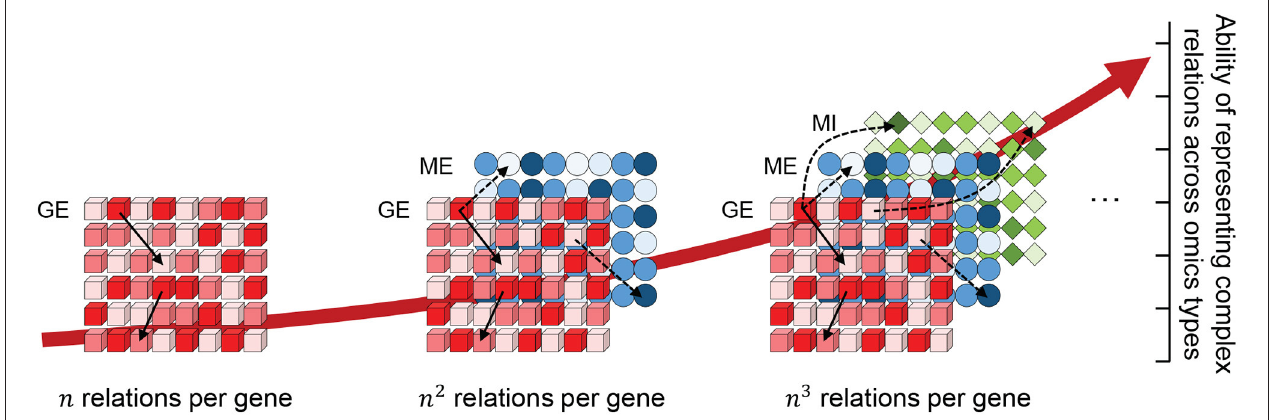
FIGURE 1 | The possible number of relations that a gene can have across omics layers (GE, gene expression; ME, methylation; MI, miRNA) increases exponentially with each omics data type added to the integration. Here, n indicates the number of genes within a single omics